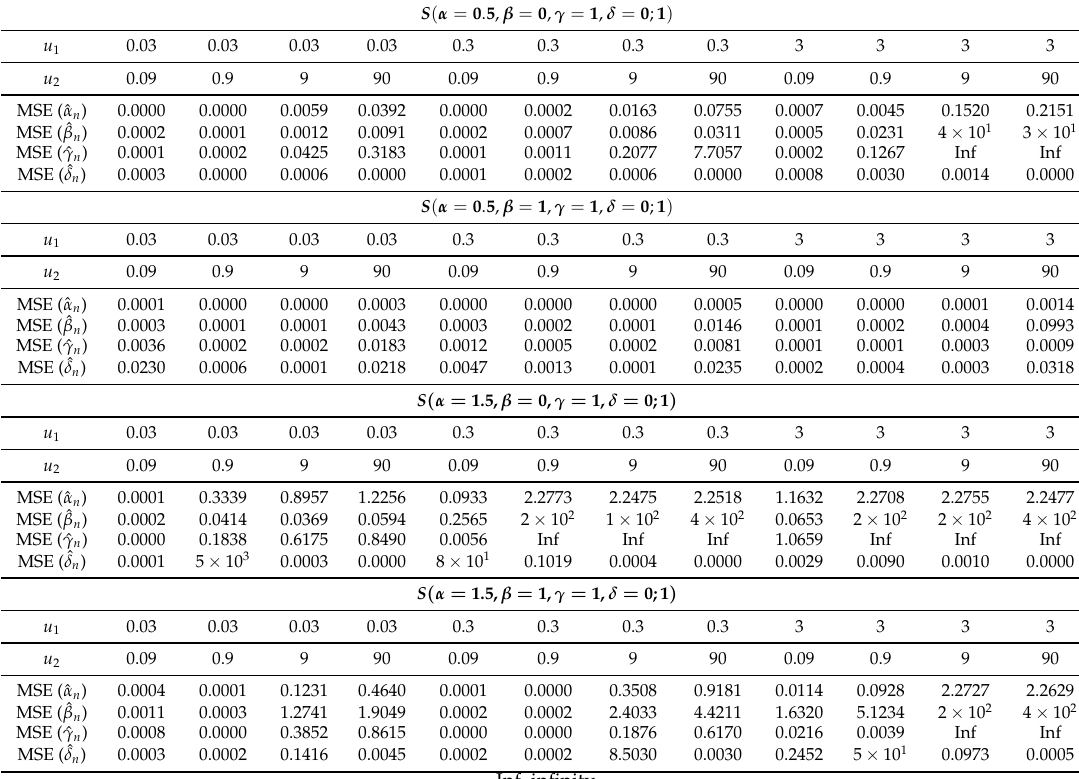
Table A1. The MSEs of reduced values’ cumulant estimates for the selection of u 1 , u 2 for 200 replicates (sample size n = 10 5 ) from S ( α , β , γ = 1 , δ = 0 ; 1 ) .